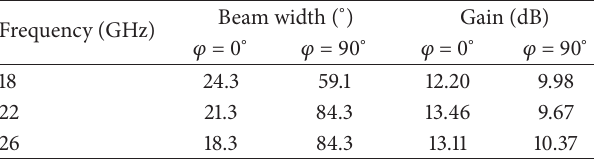
Table 2: Measured beam width and gain of IMF-CBSA array. Frequency